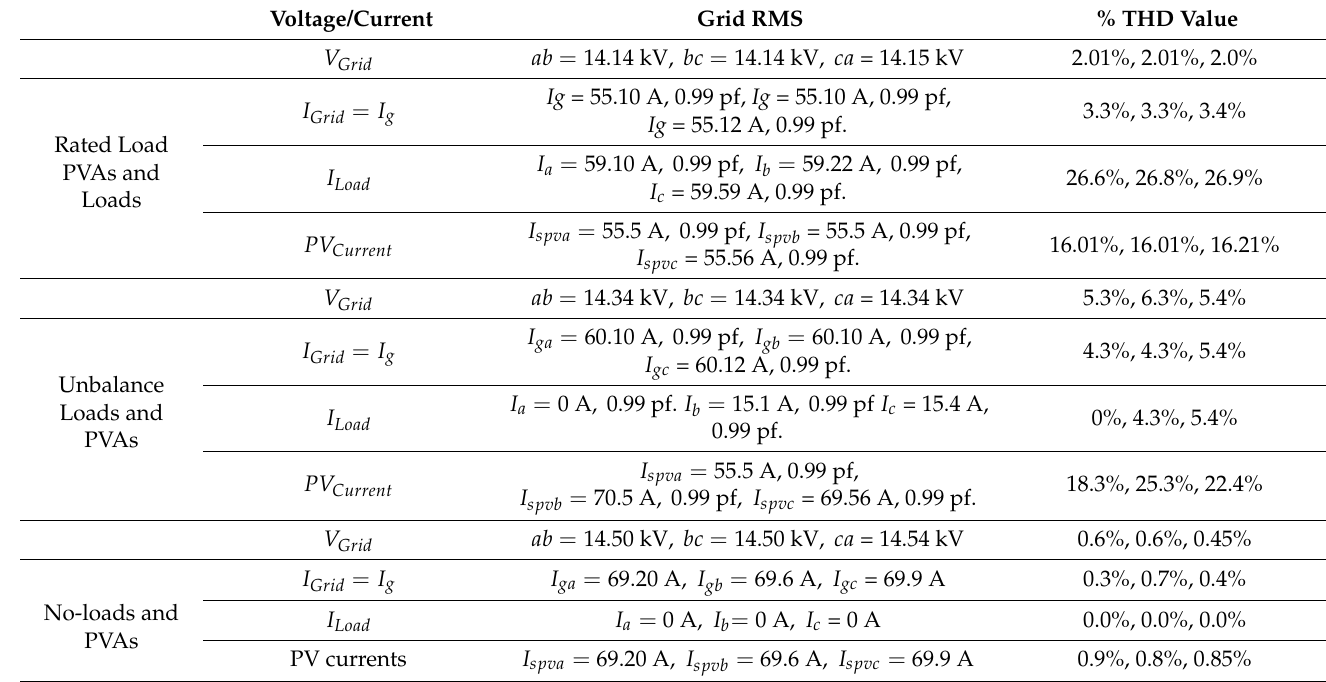
Figure 15. ( a ) PCC Voltage, Grid Current, Load Current, and PV Current, ( b ) Grid Reactive Power (0–1.15 kVAR), ( c ) Grid Reactive Power (1.15–5 kVAR), ( d ) Phase Voltage, ( e ) Solar Irradiance, ( f ) Normal Rated Power, ( g ) Flow of PCC Voltage and Grid Current, ( h ) Grid Power, ( i ) Load Power and ( j ) Reactive Power. Table 1. Grid RMS Value of Various Voltage/Current.